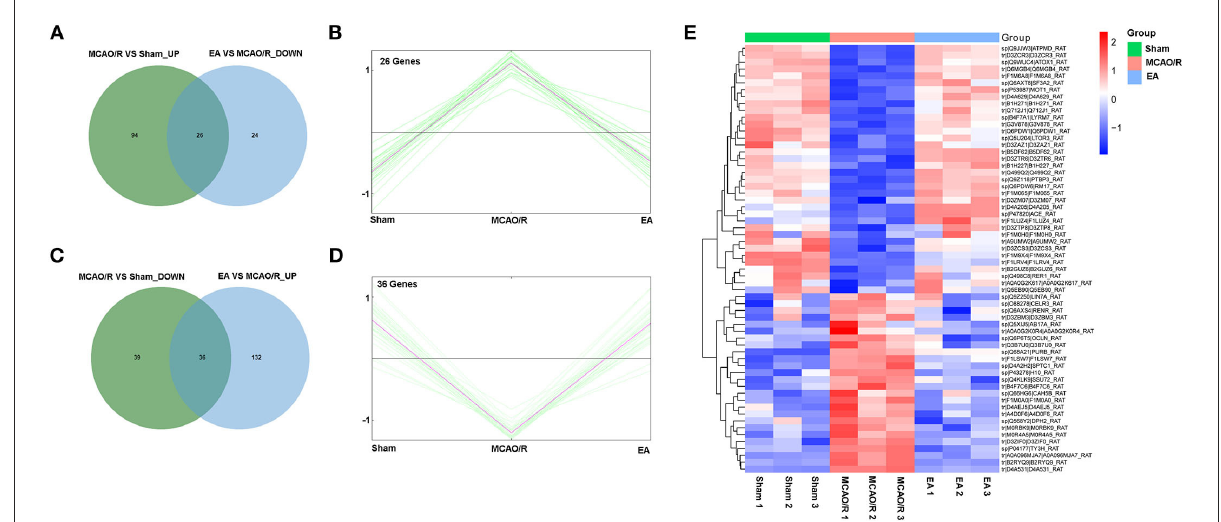
FIGURE5 Identification of proteins with adverse alteration trends in the MCAO/R vs. sham and EA vs. MCAO/R groups. (A) Jvenn analysis of upregulated proteins in the MCAO/R vs. sham group and downregulated proteins in the EA vs. MCAO/R group. (B) K-means clustering plot of the expression profiles of proteins that were upregulated in the MCAO/R group vs. the sham group and downregulated in the EA group vs. the MCAO/R group. (C) Jvenn analysis of downregulated proteins in the MCAO/R vs. sham group and upregulated proteins in the EA vs. MCAO/R group. (D) K-means clustering plot of the expression profiles of proteins that were downregulated in the MCAO/R vs. sham group and upregulated in the EA vs. MCAO/R group. (E) Heatmap of 62 proteins with converse alteration trends in the MCAO/R vs. sham group and the EA vs. MCAO/R group. Each group contained nine hippocampal tissue samples isolated from nine rats and three samples per group were mixed into a proteomics specimen.